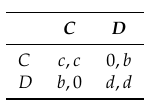
Table 1. Material